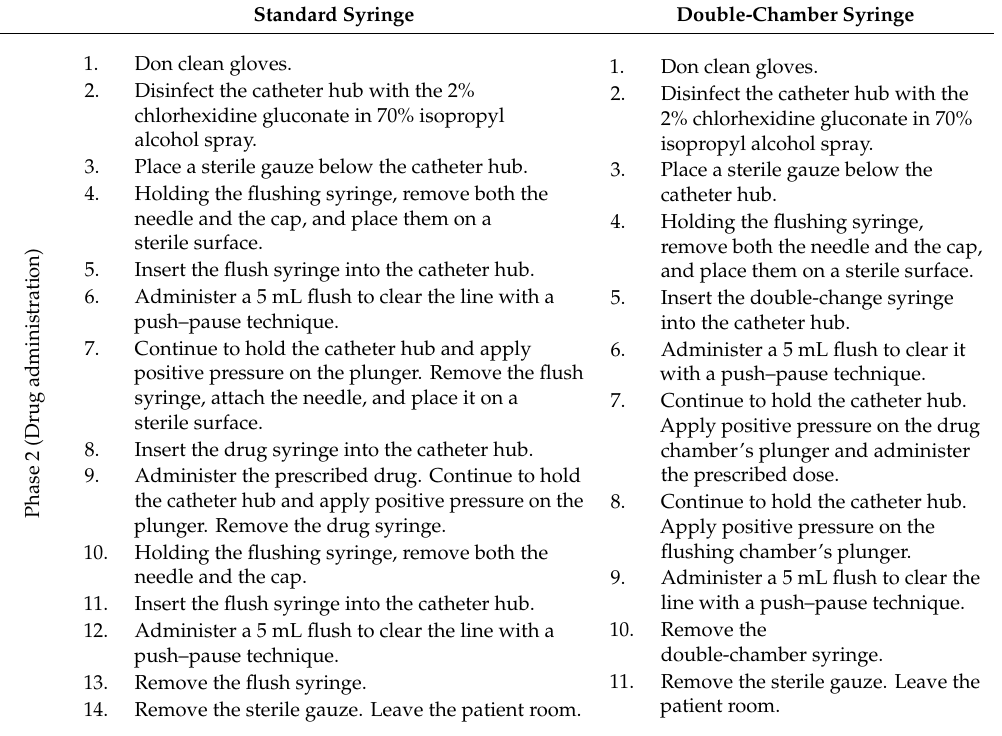
Table 4. Procedures to be accomplished by the study participants: drug administration.